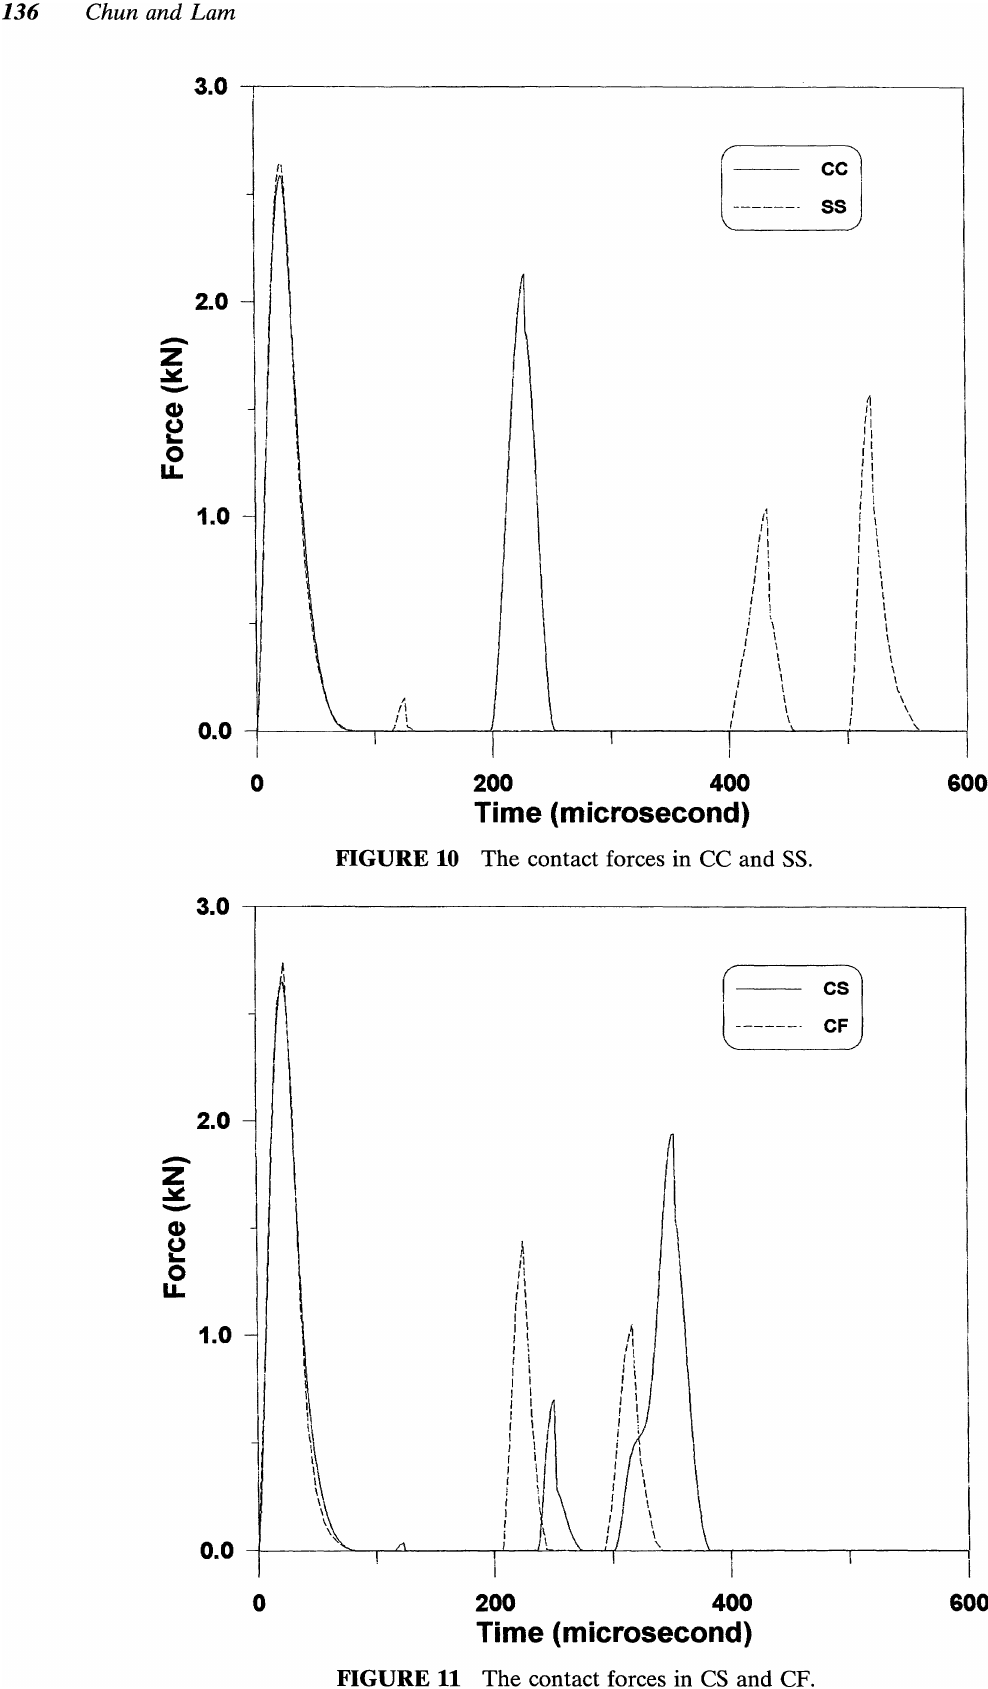
FIGURE 11 The contact forces in CS and